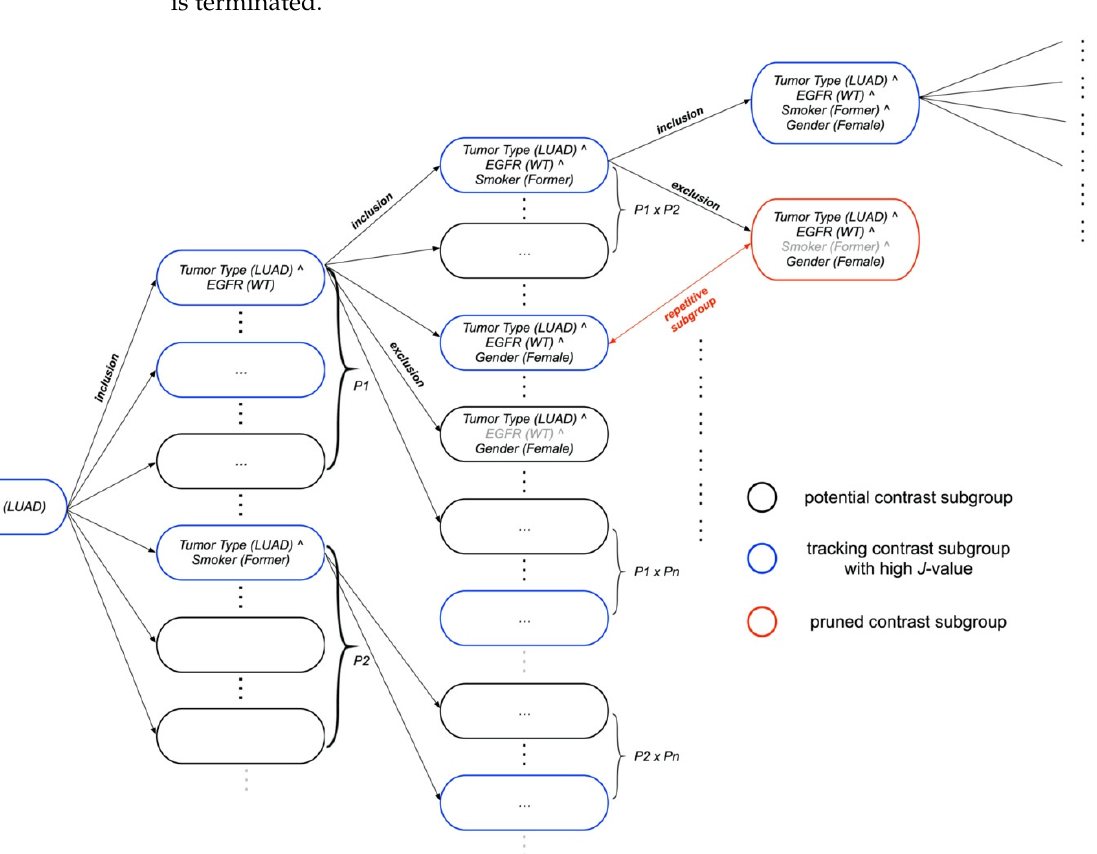
Figure 1. Subgroup Discovery module. The floating and path expansion processes initiate multiple, distinct starting points at various computational nodes. Based on the contrast score, the node is added or eliminated at each point. Each point portrays a potential subgroup. By applying contrast pattern mining, each candidate subgroup is scored against the outer population. P refers to phenotypic